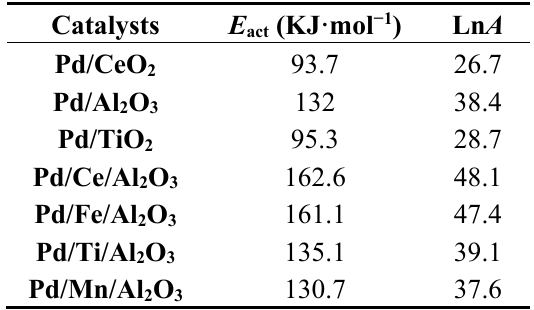
Table 5. Arrhenius parameters a , activation energy ( E act ) and pre-exponential factor A (s −1 ) of the Pd-supported